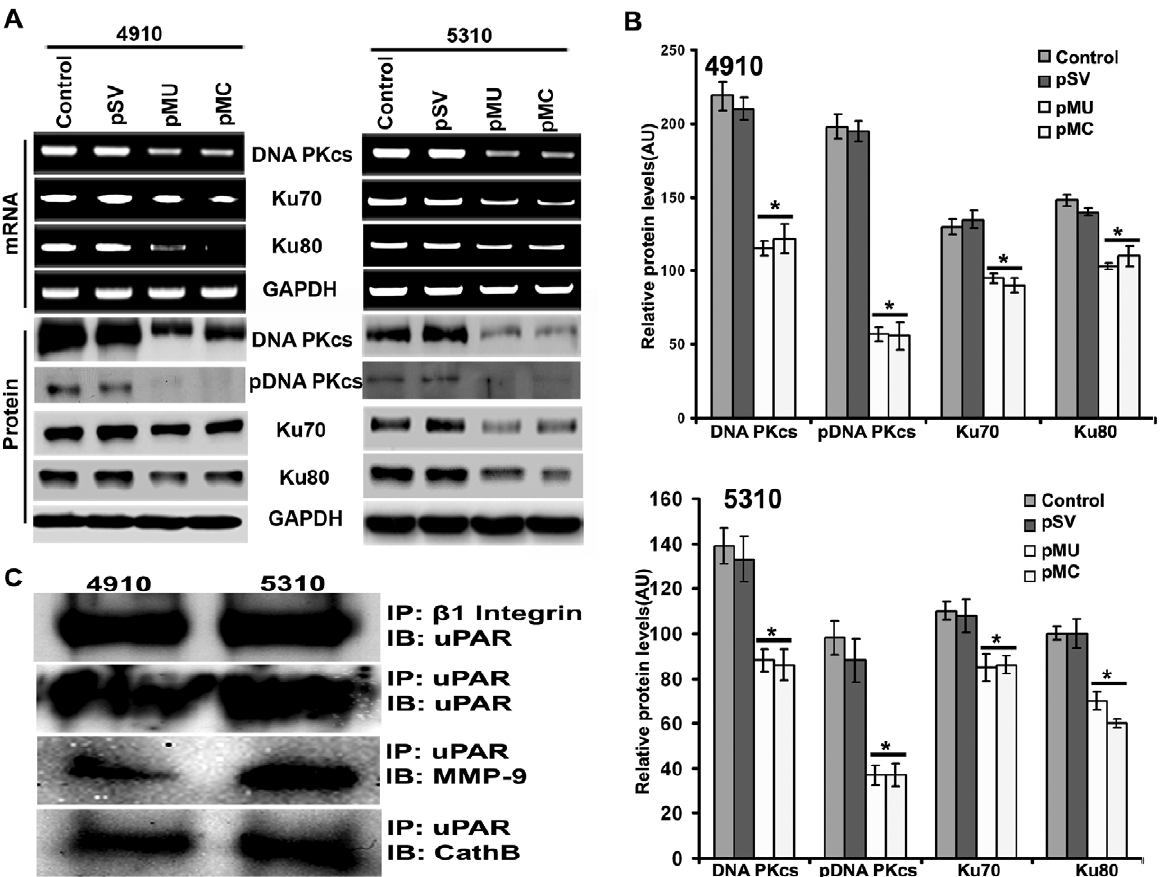
Figure 1. Downregulation of non homologous end joining DNA repair machinery by pMU and pMC in glioma xenograft cells. A. RT PCR analysis showing expression of NHEJ related genes in pMU- and pMC-treated 4910 and 5310 glioma cells. GAPDH shows equal loading. Western blot analysis performed using cell lysates prepared from pMU and pMC silenced 4910 and 5310 glioma cells showing expression of DNA PKcs, pDNA PKcs, Ku70 and Ku80. GAPDH was analyzed as loading control. Each experiment was repeated 3 times. B. Further, quantification of the Western blots using ImageJ (NIH) software to determine the levels of these proteins after pMU and pMC treatments is shown. n=3. Values shown are the mean ( 6 SD). * p , 0.05 vs. control. C. Immunoprecipitation (IP) analysis. IP of b 1 integrin was immunoprobed with uPAR in both 4910 and 5310 glioma xenograft cells. IP of uPAR was immunoprobed with MMP9 and cathepsin B in glioma cells. Each experiment was repeated 3 times.